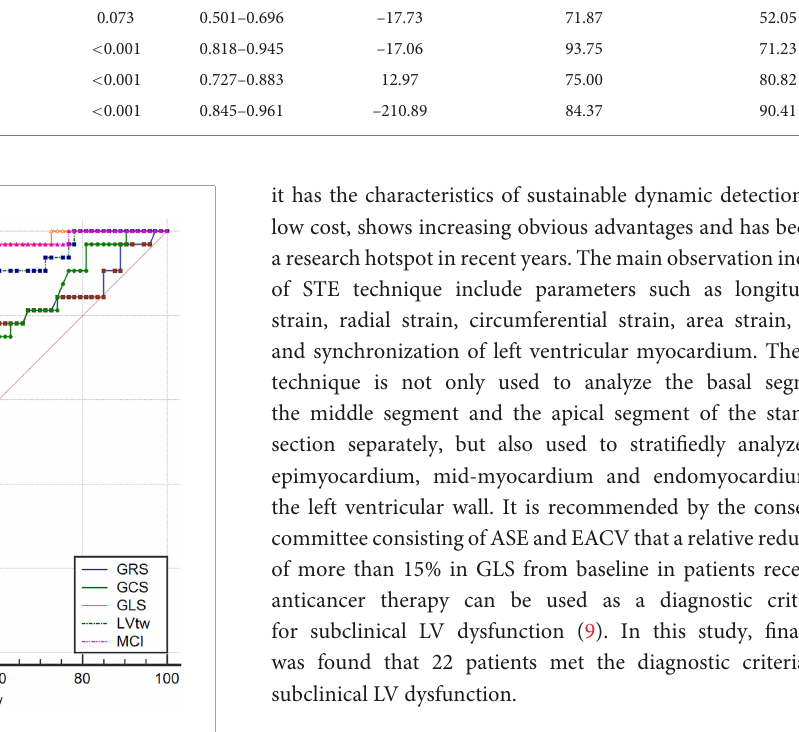
FIGURE2 ROC curve for 2D-STE parameters and